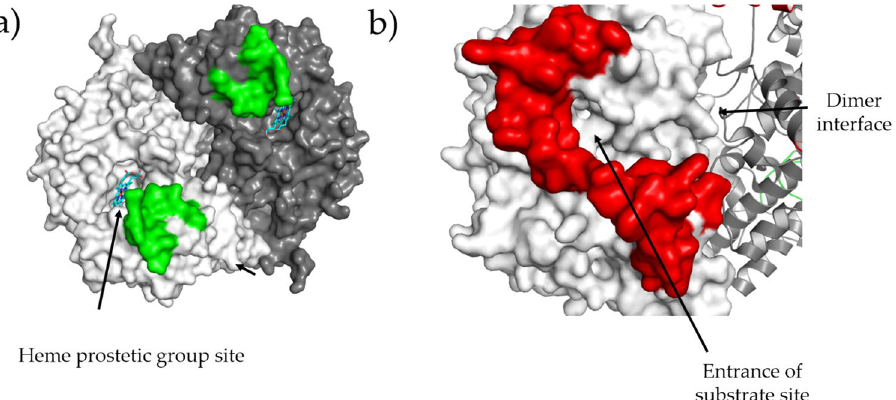
Figure 10. Regions whose conformation is peculiar for h COX-1. Protein units forming the dimer are shown in white and gray surface. ( a ) The heme molecule is shown in stick representation and the region 270–290 in green color. ( b ) The region 60–100 is shown in red